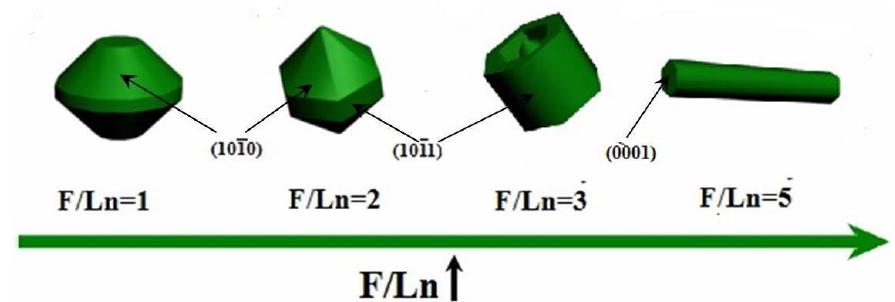
: 10% Nd 3+ ,10% Yb 3+ , 2% Er 3+ 4